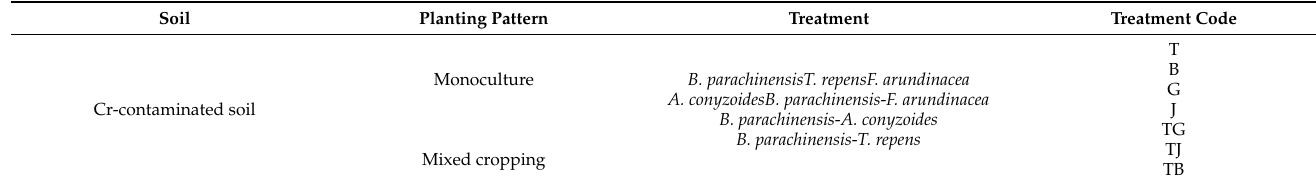
Table 2. Pot experiment